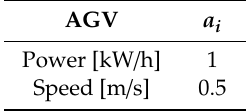
Table 5. Power \ speed of automated guided vehicle